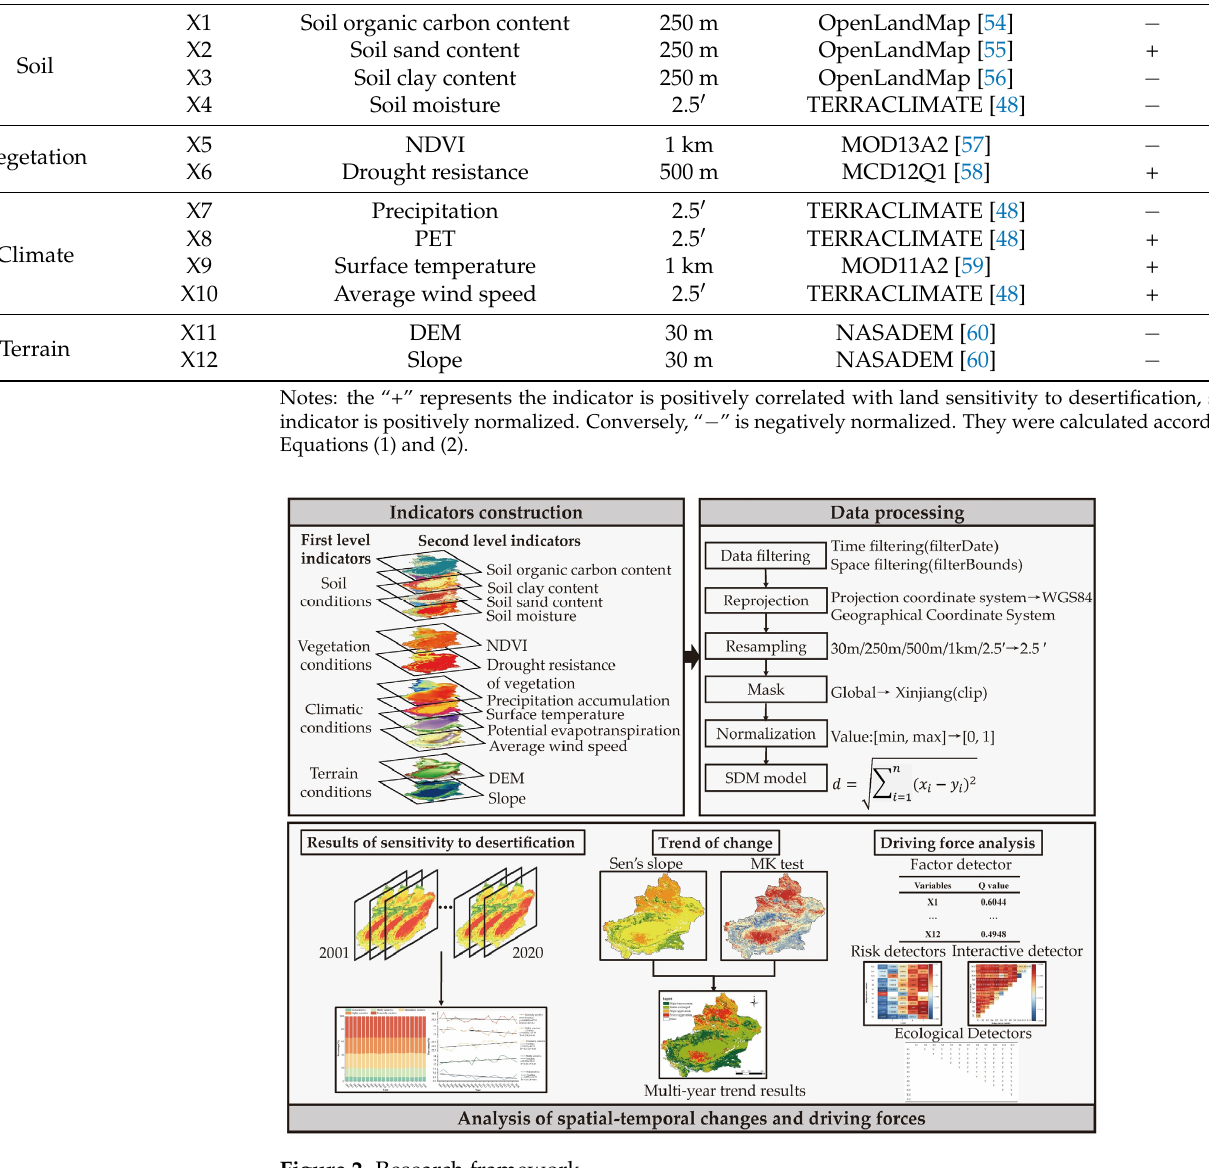
Figure 2. Research framework.